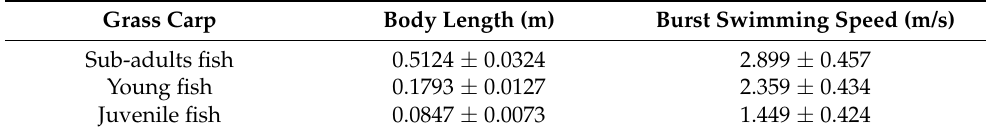
Table 3. Swimming ability of grass carp of different sizes .